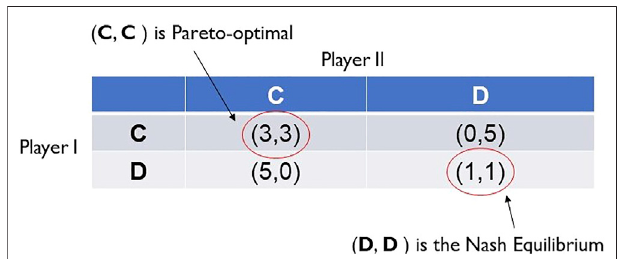
FIGURE 2 | Nash equilibrium versus Pareto-optimal outcomes in Prisoner ’ s